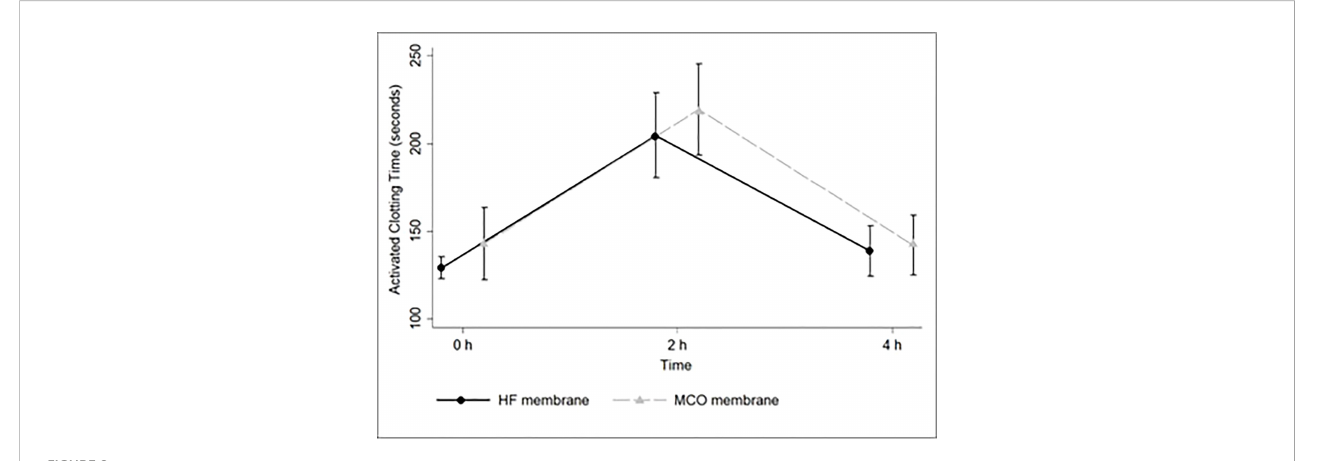
FIGURE 2 ACT curve throughout the dialysis session in the HF and MCO groups. MCO, medium cut-off membrane; HF, High Flux